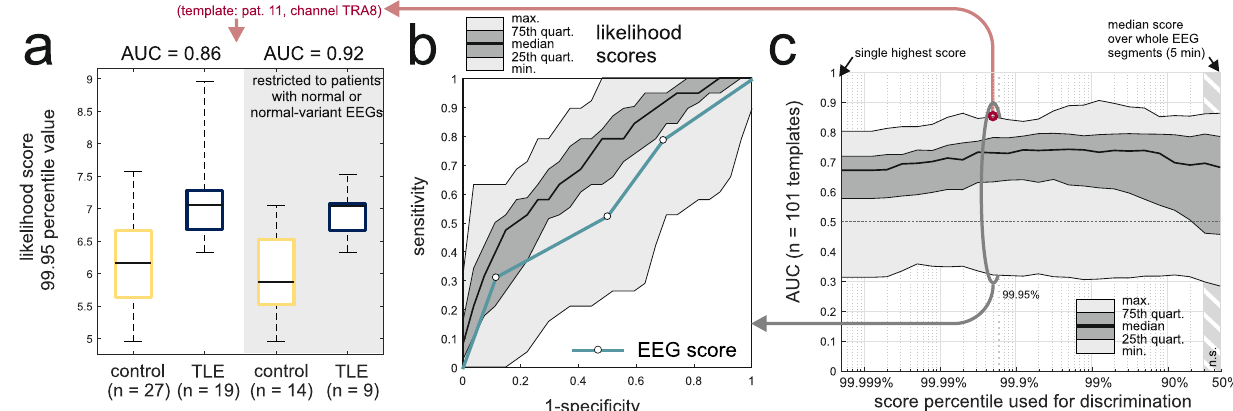
Figure 6. External validation: application of templates to classify TLE subjects vs controls. ( a ) Example of a template for which the 99.95th percentile values of likelihood scores discriminate between patients with TLE and control subjects also in the case when the analysis was restricted to those with normal and normal-variant scalp EEGs (grey background). ( b ) Range of AUC curves for all studied templates and likelihood score 99.95th percentile-based discrimination shown together with a ROC curve derived from clinical review of scalp EEGs (AUC = 0.58). At high-sensitivities template-based classification outperforms visual scalp EEG analysis. Both approaches perform comparably at high specificities. ( c ) Dependence of AUC values on the fixed percentile threshold. Performance of the studied set of templates was stable at AUC ~ 0.7 and significantly higher than AUC = 0.5 throughout most of the